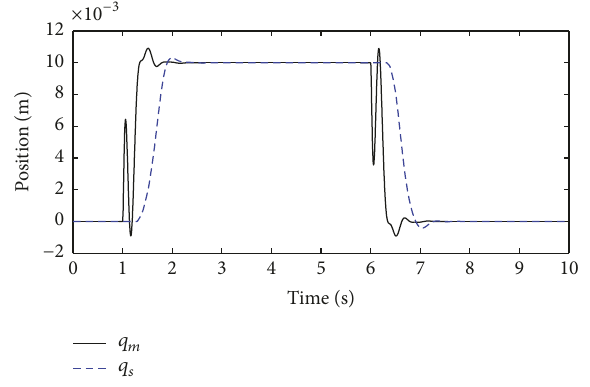
Figure 15: Position tracking performance ( 𝑇 𝑖 (𝑡) = |𝑋 𝑖 (𝑡)| (𝑖 = 1, 2),𝑋 ∼ 𝑁(0.4, 0.01) ). 𝑖